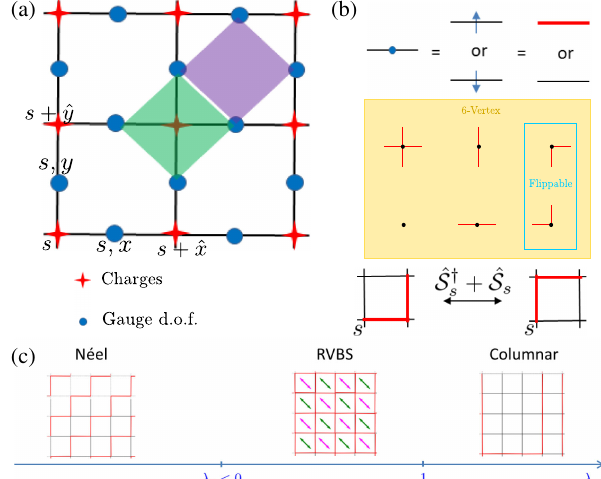
FIG. 1. Spin gauge theories and the Rokhsar-Kivelson model. (a) Spin- 1 = 2 lattice gauge theories are the simplest gauge theories with a continuous gauge symmetry group. The gauge degrees of freedom are spins 1 = 2 that live on the oriented links of the lattice, labeled as s , μ , where s is the starting site and μ is the direction, e.g., x or y in a square lattice. They display the main features of gauge theories in D > 1 : (i) the Gauss law that determines the allowed spin configurations on the links in terms of the charges and (ii) the magnetic interactions acting on the links around a plaquette. On a square lattice, these operators correspond to both four-body spin operators indicated by the green and violet rhombi, respectively. (b) In a system without charges, we depict the effect of the Gauss law by coloring in red the links in j ↑ i and not coloring the ones in j ↓ i that represent the electric states. Physical states are a superposition of endless red strings going up and right [see (c) and Fig. 2]. Such electric configurations ˆ S † ˆ S correspond to position states, and acts as a kinetic term s þ s ˆ S † ˆ S 2 is on them. (c) The square of the plaquette operator ð s Þ s þ diagonal in the electric basis and plays the role of a potential term that counts flippable plaquettes. The competition of the kinetic and potential terms in the Rokhsar-Kivelson Hamiltonian (4) gives rise to a rich phase diagram, with the resonating valence bond solid (RVBS) phase separating two crystal phases, the N´eel and the columnar phases (see the description in the main text). The resonant plaquettes are depicted by diagonal double arrows. The alternated green and pink arrows reflect that the resonant plaquettes are correlated within the same sublattice and anti- correlated with the ones in the opposite